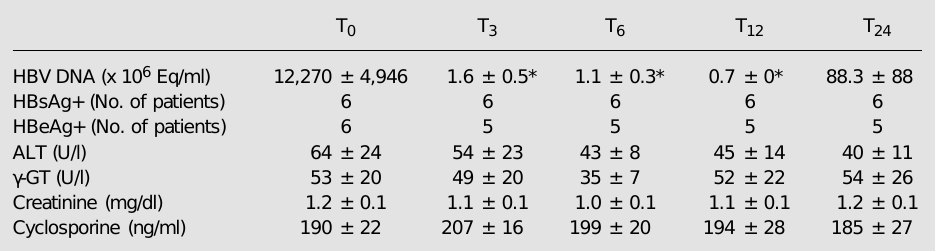
Table 1. Laboratory evaluation of renal transplant patients with hepatite B virus (HBV) infection treated with lamivudine. T 0 T 3